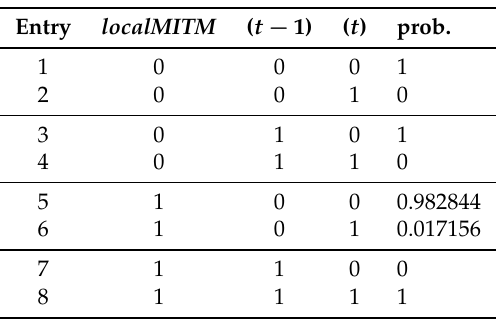
Table 1. Conditional probability table of the variable SpoofRepMsg . Entry localMITM ( t − 1) ( t )